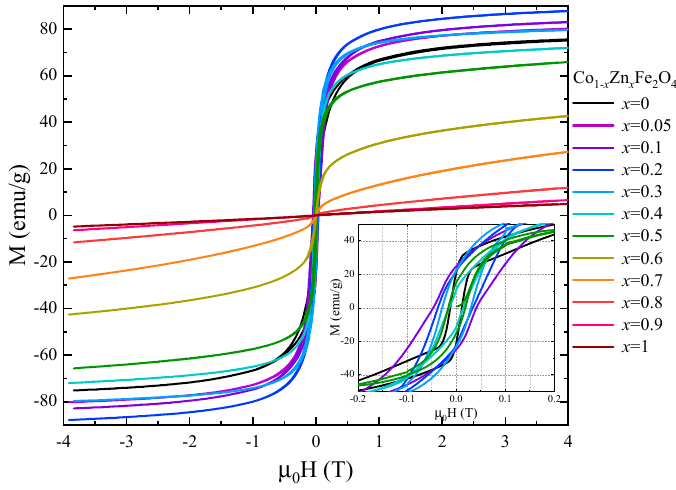
Figure 9. Hysteresis loops recorded at room temperature for Co 1 − x Zn x Fe 2 O 4 nanoparticles. The magnetically induced heating capabilities of five samples were investigated in water at one certain concentration of 1 mg MNPs /mL. The Box–Lucas function was employed to fit the heating curves and the resulting parameters were used to evaluate the specific absorption rate (SAR) in watts per unit mass of MNPs (W/g MNPs ). The SAR values